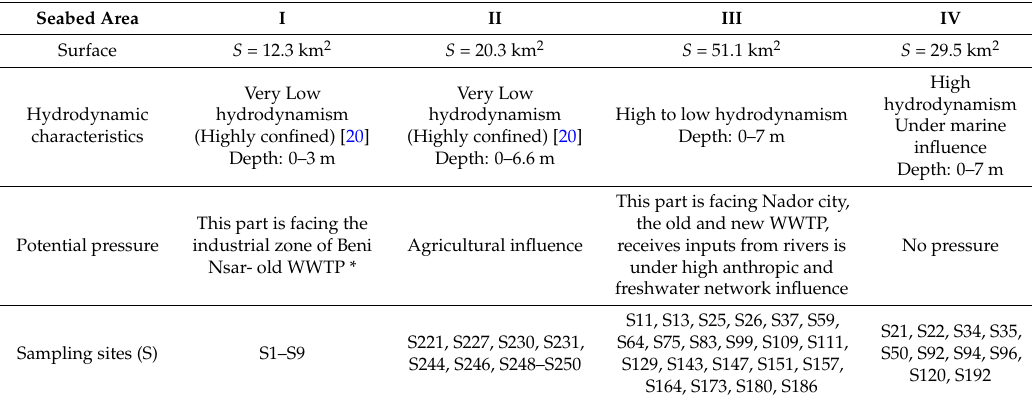
Figure 3. Lagoon map showing sampled sites along the seabed. Table 1. Sampling points and description of sampling network characteristics.